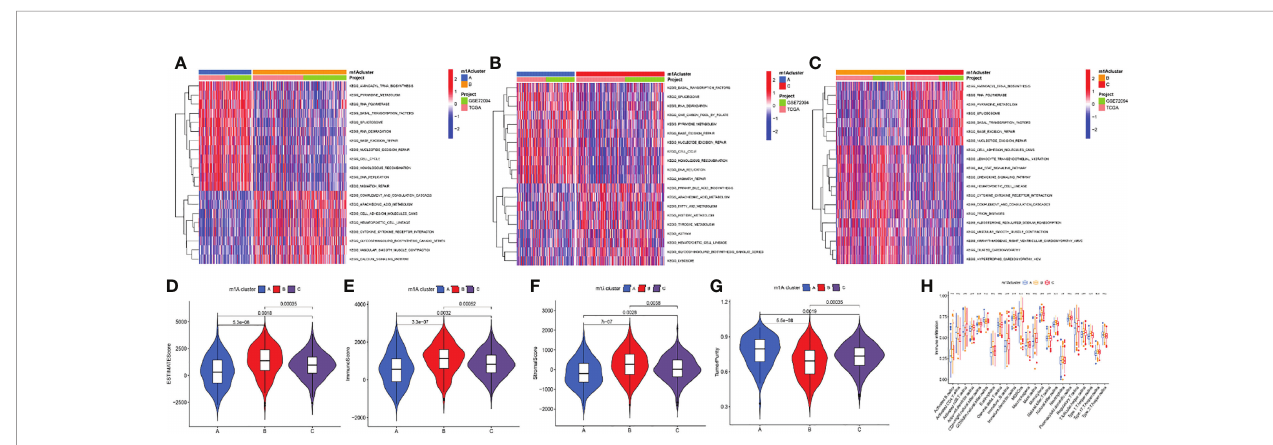
FIGURE 3 | Differences of biological features and immune pro fi les of three m1A clusters in LUAD. (A – C) GSVA results revealed speci fi c biological pathways of three m1A modi fi cation patterns. (A) Cluster A vs. cluster B; (B) cluster A vs. cluster C; (C) cluster B vs. cluster C. (D – G) Violin plots depicted the distribution of ESTIMATE, immune, and stroma scores as well as tumor purity in three m1A modi fi cation patterns. (H) Differences in abundance of 23 TME-in fi ltrating cells under three m1A modi fi cation patterns. ** indicates p < 0.01; *** indicates p <